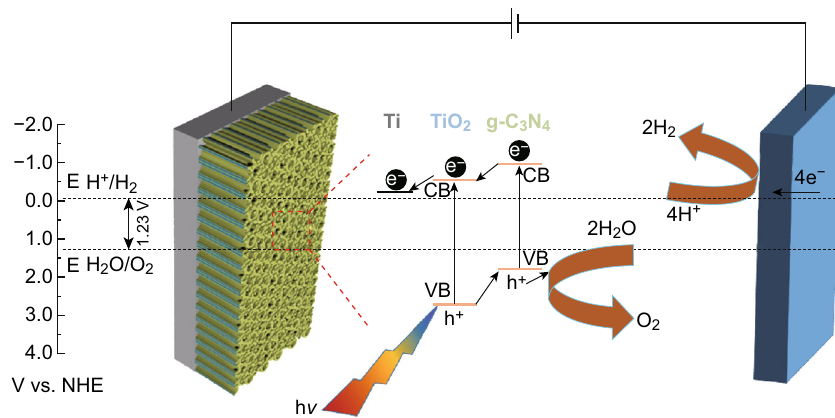
Fig. 11 Schematic diagram of the charge transfer mechanism of the g-C 3 N 4 /TNTA heterojunction